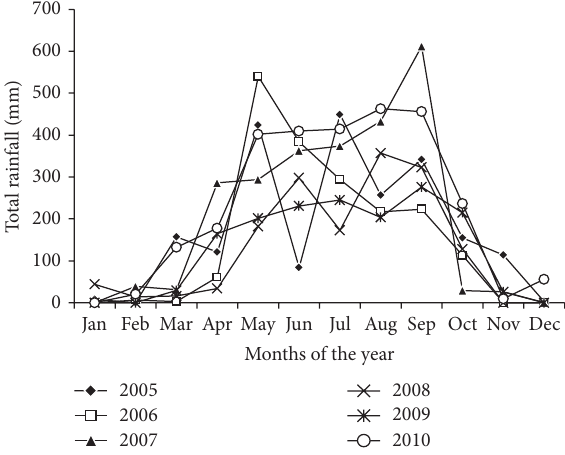
Figure 1: Rainfall data of the study area over the past six